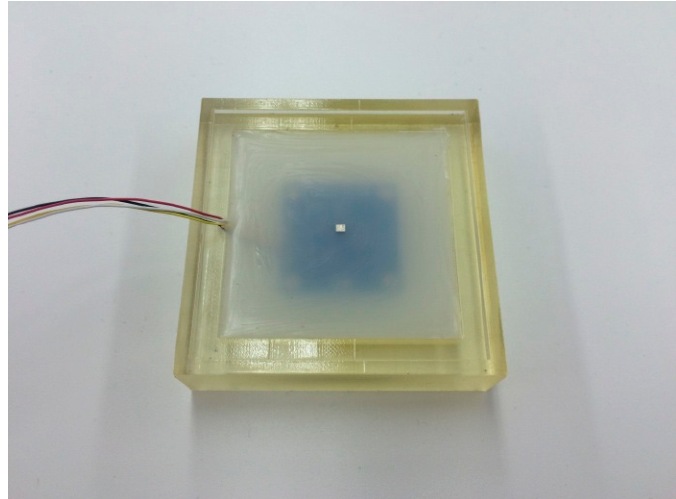
Figure 2. The prototype of the Hall effect–based skin sensor.